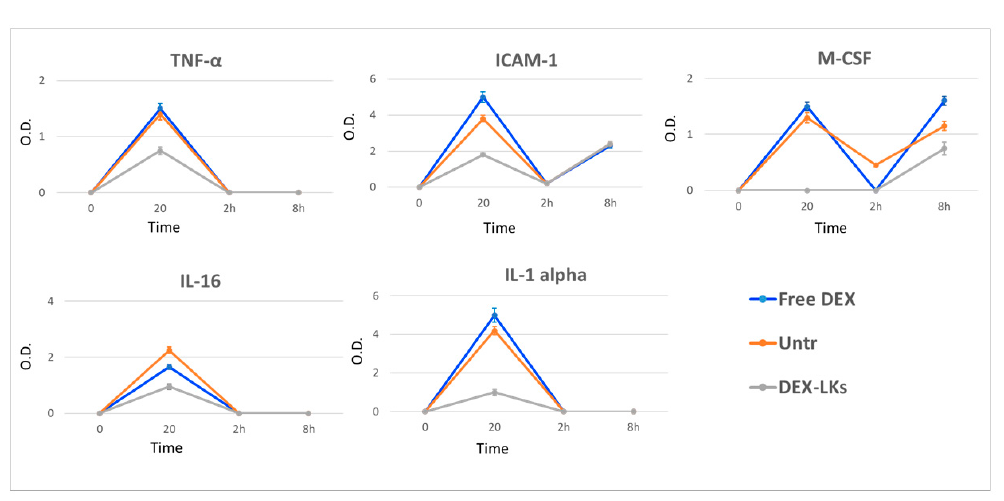
Figure 4. Levels of inflammatory cytokines following treatment. The average net optical intensities (O.D.) for each cytokine are shown for each group at different time points. The basal levels of plasma cytokines of non-treated mice were evaluated by the same array and used to normalize the data. Results are presented as mean ± SD (n = 4).